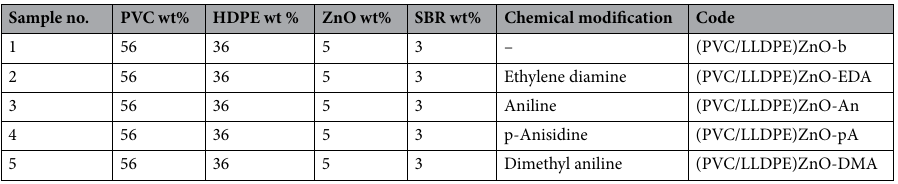
Table 1. represents the code of samples of amine-functionalized of PVC.